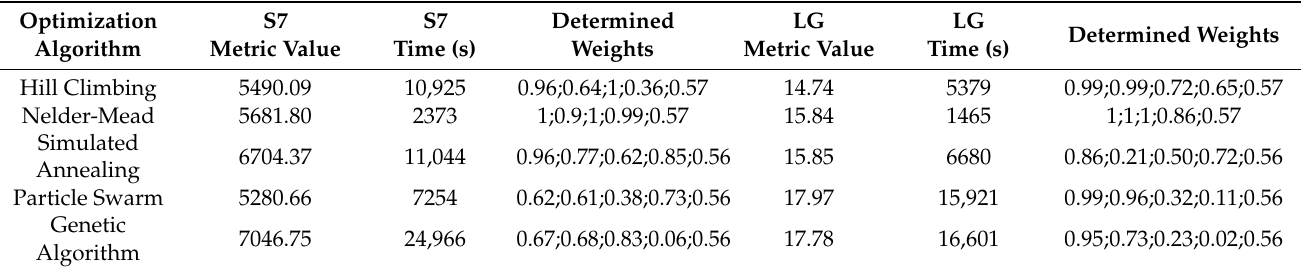
Table 2. Performance analysis. The weights represent the walkway structure, BLE and WLAN fingerprinting, magnetic field anomalies, and step length estimation.